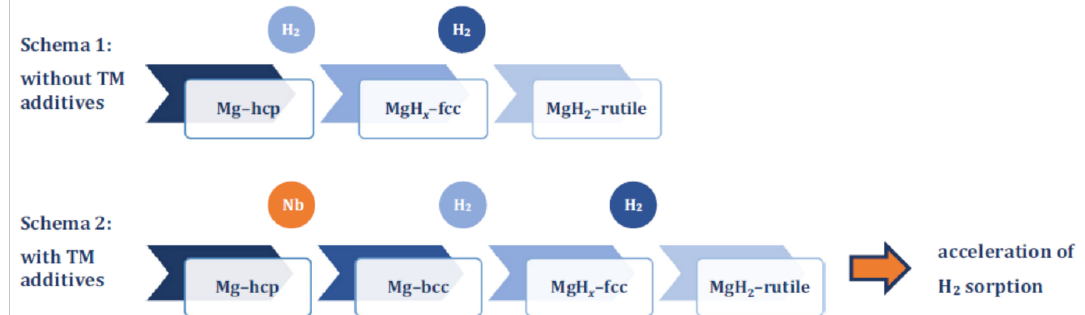
Figure 35. Scheme of hydrogen-induced structural phase transitions in Mg with and without TM additives. Reproduced with permission [42]. Copyright 2015,